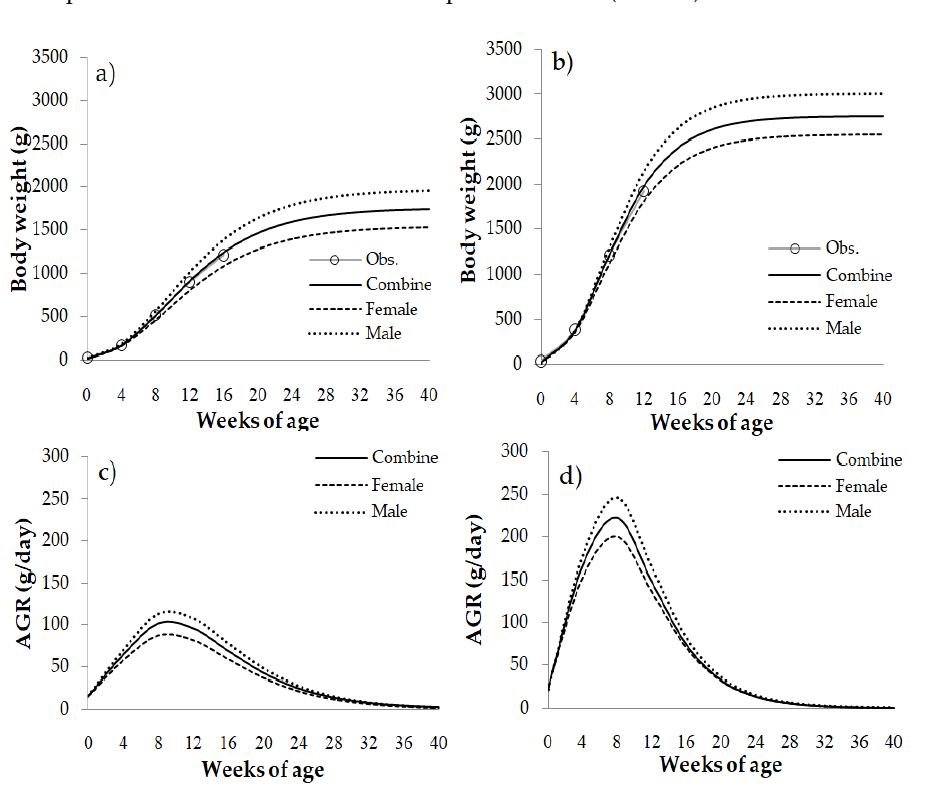
Figure 4. Characteristics of the estimated growth curves (body weight and the absolute growth rate [AGR]) using the Gompertz function in purebred Thai native chickens ( a , c ) and Thai synthetic chickens ( b , d ).